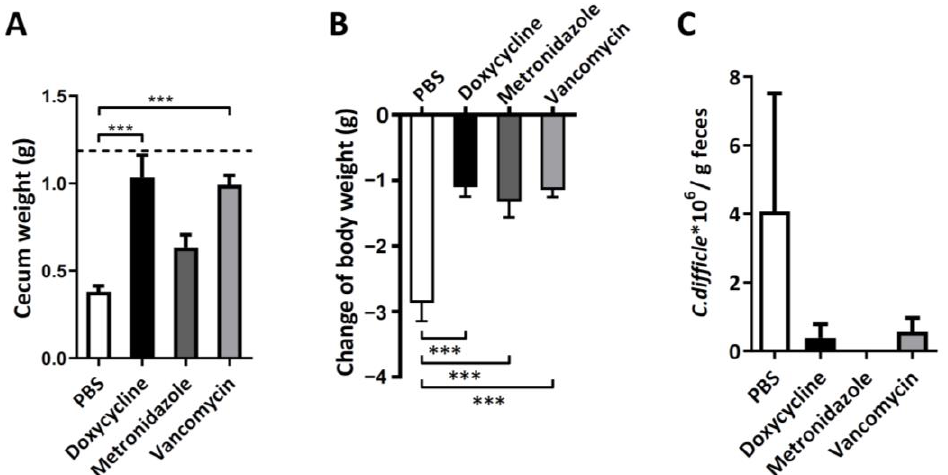
Figure 4. Therapeutic effect of oral doxycycline on C. difficile infection model: Cecum weights ( A ), body weight changes ( B ), and fecal Clostridioides difficile bacterial load ( C ) of C. difficile -infected mice receiving PBS, doxycycline, metronidazole, or vancomycin therapy. The results of the uninfected group are demonstrated by a dashed line. The values are expressed as the means ± standard errors (***, p < 0.0001).